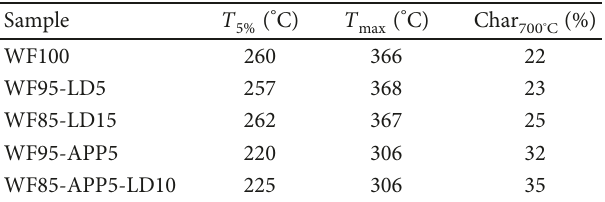
Table 4: Thermal data of WFP measured through TGA.